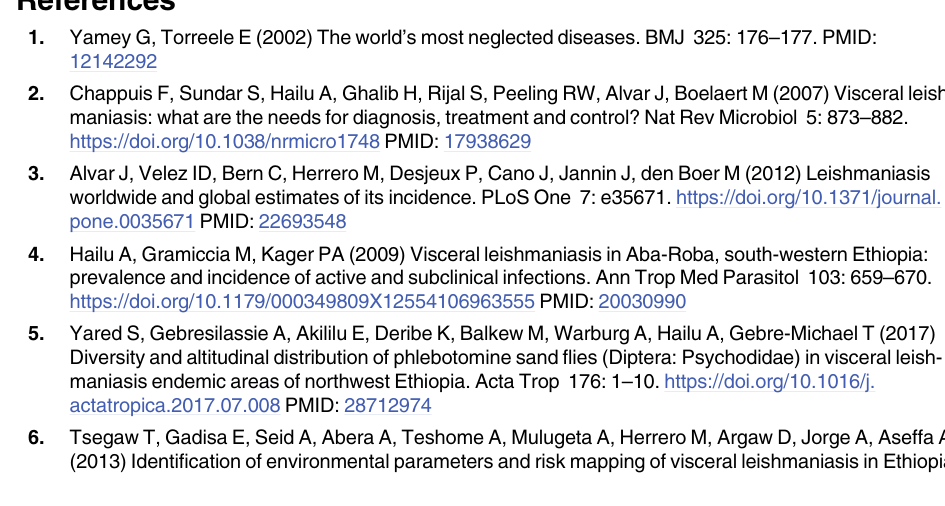
S2 Table. Characteristics of the study population participating in